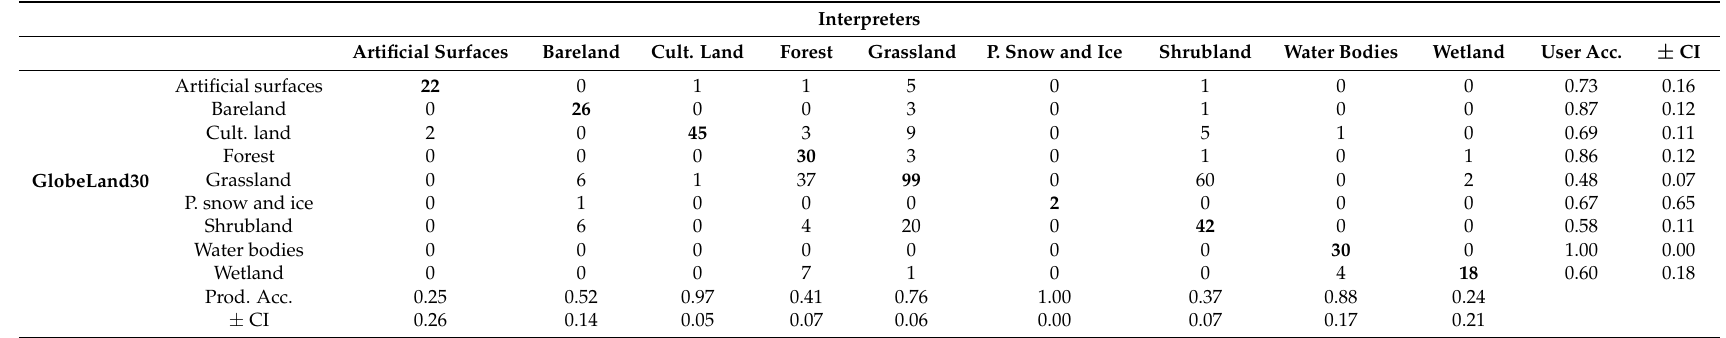
Table 6. Confusion matrix for Sample 2 ( n = 500) considering either choice 1 or choice 2 when present (which occurred in 12.2% of the sample). User’s and